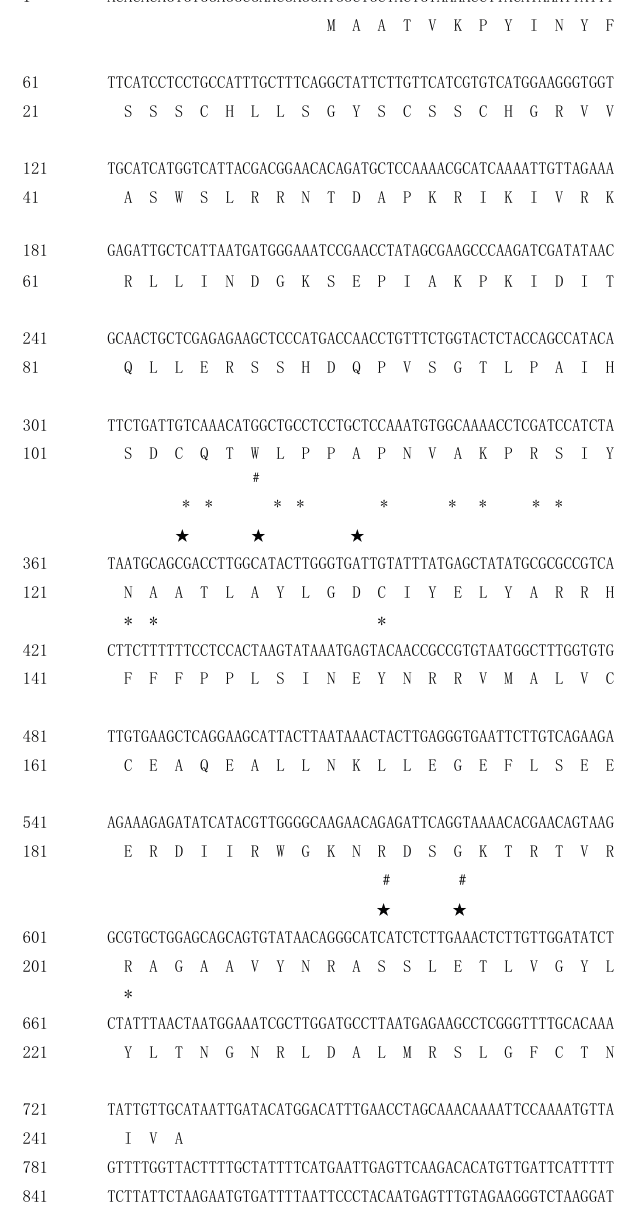
Figure 4. Full length cDNA sequence and deduced protein sequence of Cl RTL1 . ★ : active site; #: metal binding site; *: dimerization